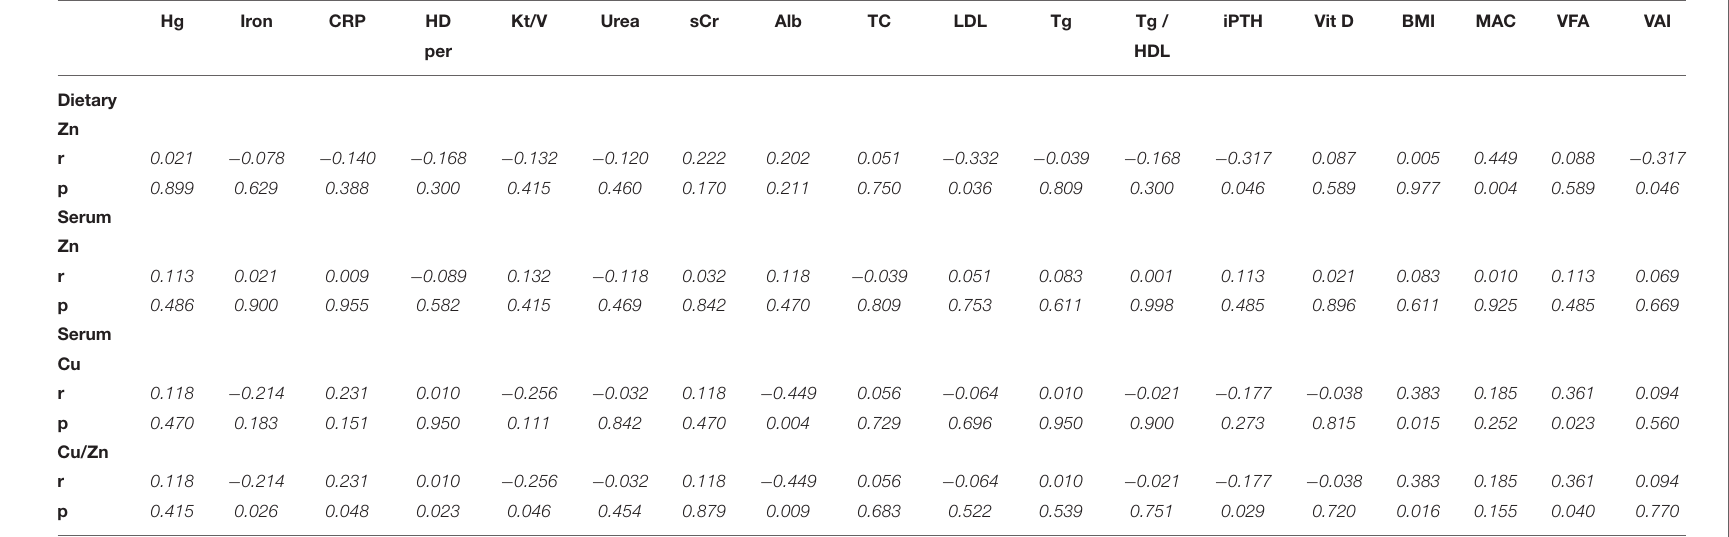
TABLE 4 | Correlation between zinc intake and status values with the different biochemical parameters in hemodialysis patients.